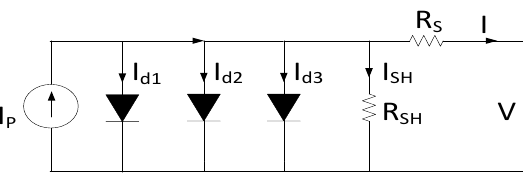
Figure 3. Equivalent circuit of the three-diode model PV